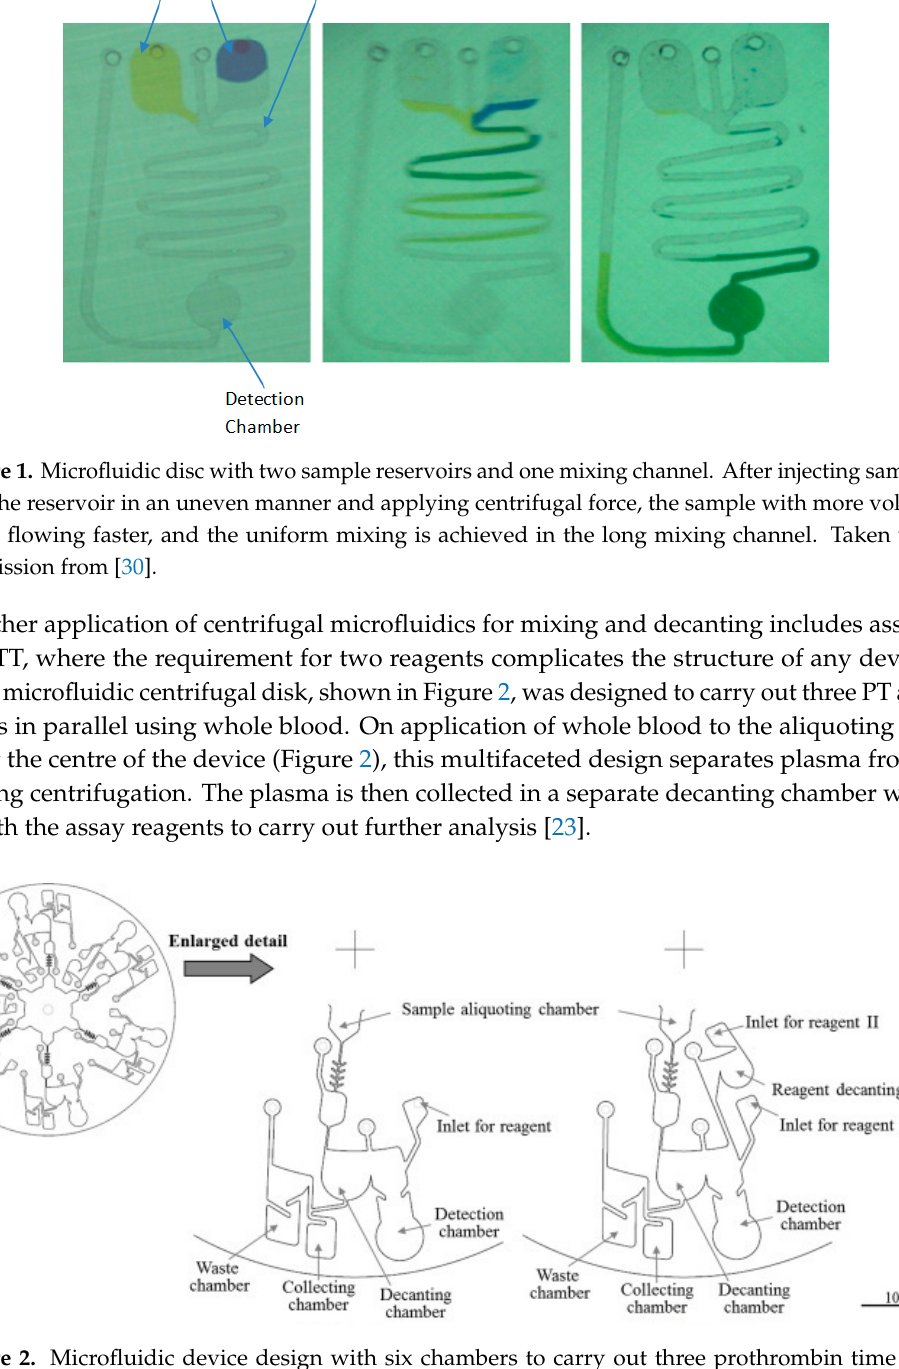
Figure 2. Microfluidic device design with six chambers to carry out three prothrombin time (PT) requiring one reagent inlet and three activated partial thromboplastin time (aPTT) assays that require inlets for reagents I and II. Taken with permission from [23].